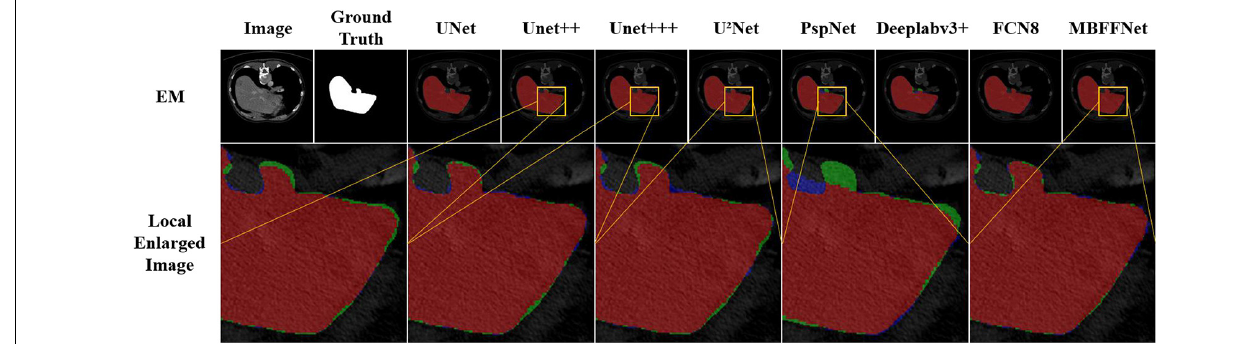
FIGURE 7 | Segmentation effect of liver lesions.